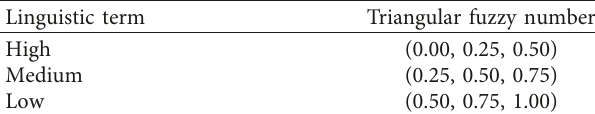
Table 2: Linguistic variables and membership